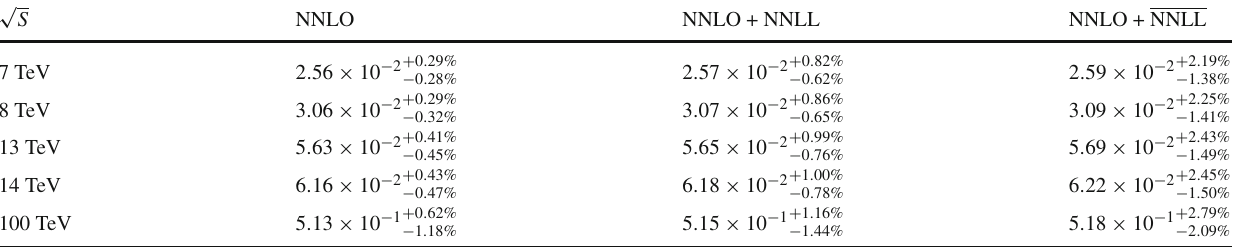
Table 13 Resummed results for invariant mass distribution of di-lepton pair against fixed-order (in pb/GeV) at different centre of mass energies at the LHC for Q = 500 GeV